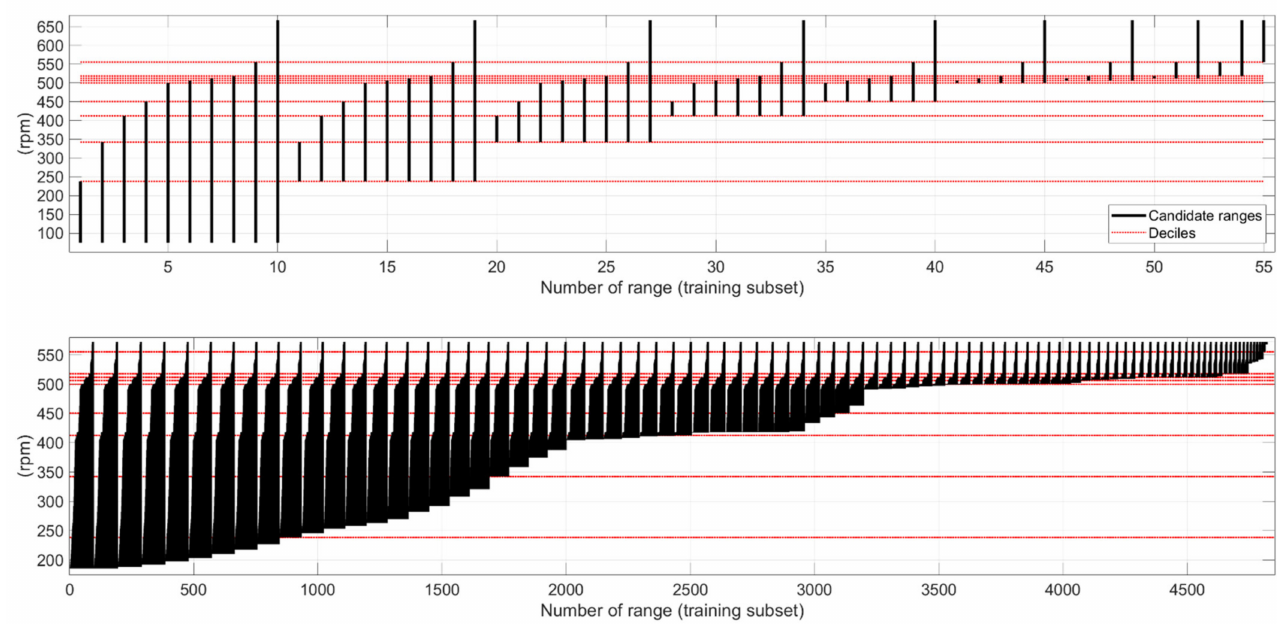
Figure 2. Candidates for monitored speed ranges based on two approaches to dataset segmentation, demonstrated with one training set (N = 3000): ‘Basic training subsets’ approach with 55 ranges is illustrated on top; ‘Adaptive training subsets’ approach with 4851 ranges is shown